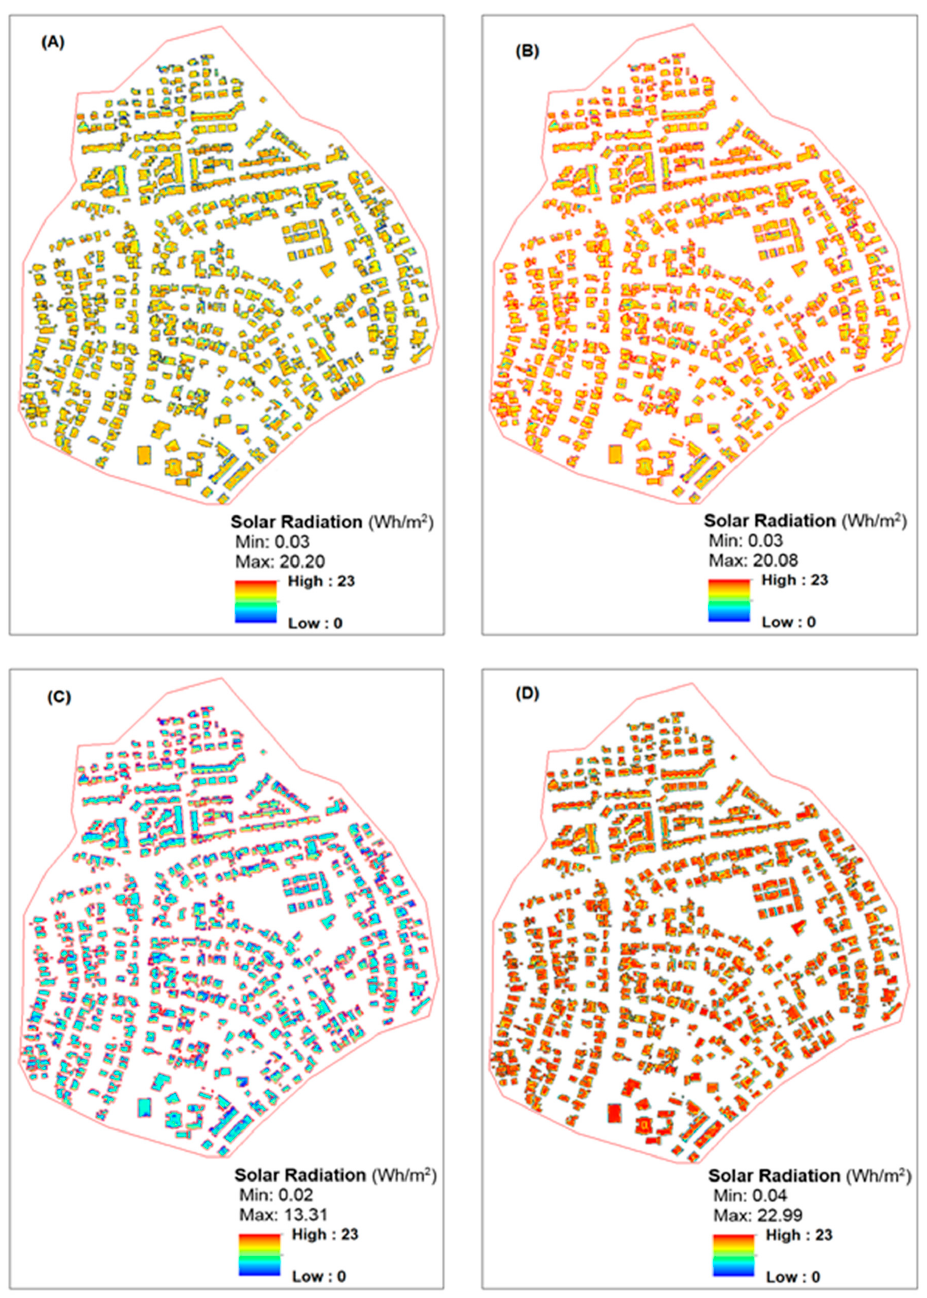
Figure 10. Incoming solar radiation (Wh / m 2 ) at 12:00: ( A ) vernal equinox (21 March), ( B ) autumnal equinox (23 September), ( C ) winter solstice (22 December), and ( D ) summer solstice (21 June).